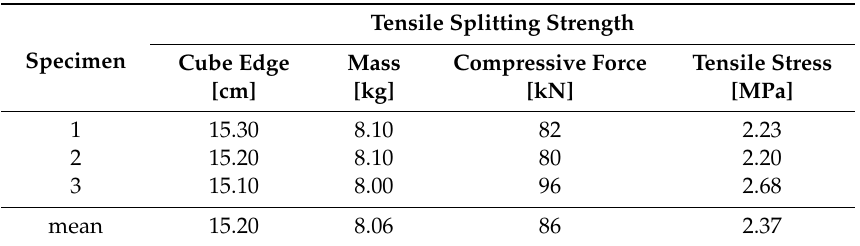
Table 5. The results of tensile splitting